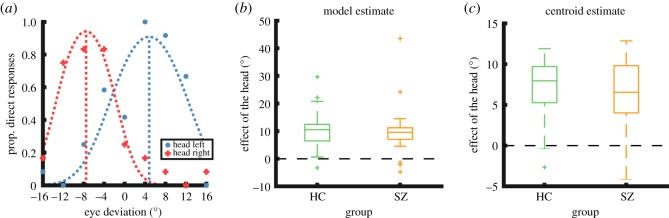
(a) An example of individual participant data, showing the proportion of direct responses as a function of stimulus eye deviation. Negative values on the x-axis indicate leftwards eye deviations. Face stimuli with head orientation 20° left and 20° right are plotted separately. The dotted lines show a psychophysical model of perceived gaze direction fitted to the participant data for each condition. The average difference between the eye deviation at which the peaks of the two model functions occur (i.e. the cone model half-difference) is a measure of the effect of head orientation on perceived gaze direction. This specific participant shows a cone model half-difference of approximately 6°, indicating that head orientations of 20° tend to draw the perceived gaze direction about 6° away from veridical. (b) The estimated effect of head orientation on perceived gaze direction, for healthy controls (HC) and participants with schizophrenia (SZ). Here the effect of head orientation is quantified in terms of the cone model half-difference obtained by fitting the model of perceived gaze direction to the data. Both groups exhibit a strong effect of head orientation on perceived gaze direction. See §3.1 for statistics. (c) The estimated effect of head orientation on perceived gaze direction, quantified by finding the average difference between the centroids of the data for the two head orientation conditions (i.e. the centroid half-difference). These data support the same conclusions as the modelling approach. See §3.2 for statistics.